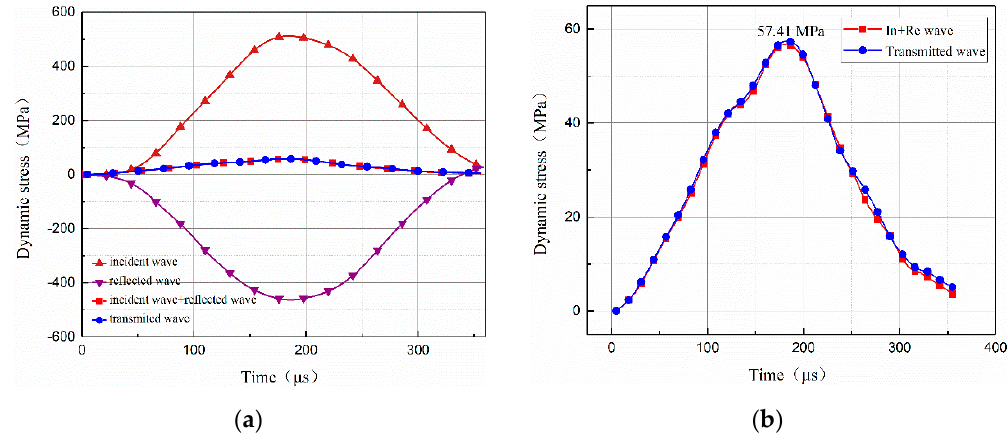
Figure 4. Dynamic stress curves. ( a ) Dynamic stress curves of the incident bar and transmitted bar. ( b ) Dynamic stress curves in the experiment.